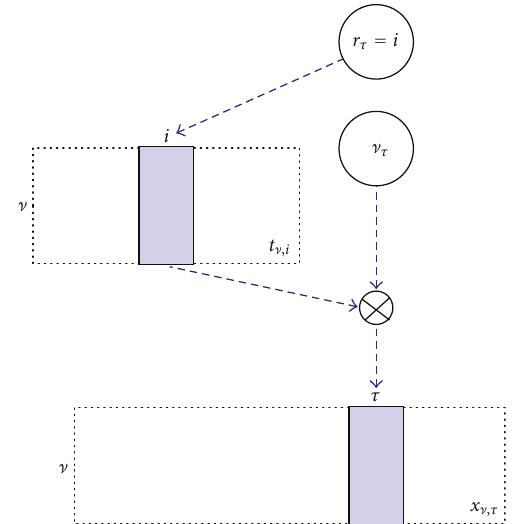
Figure 1: The block diagram of the probabilistic model. The indicator variables r τ define the template to be used. The chosen template is multiplied by the scaling parameter v τ in order to obtain the magnitude spectrum, x ν , τ